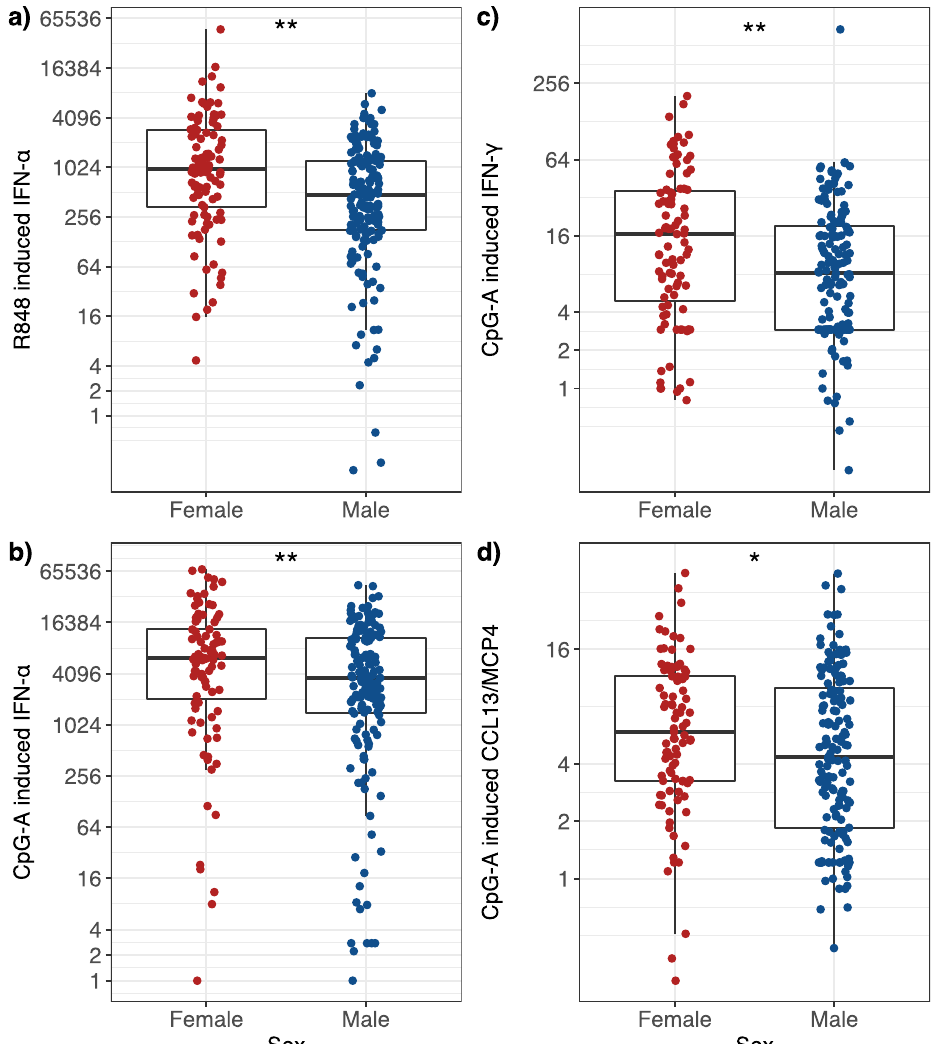
Figure 4. Females have significantly greater induction than males of type I and II IFNs and CCL13/MCP4 in response to the viral mimics R848 and CpG-A. Box plots represent the 25th and 75th percentiles, the line the median, with whiskers at the 10th and 90th percentiles. Each dot represents an individual participant. Data were analysed using the Wilcoxon test. Adjusted P values: ( a ) P = 0.002, ( b ) P = 0.051, ( c ) P = 0.017 and ( d ) P =